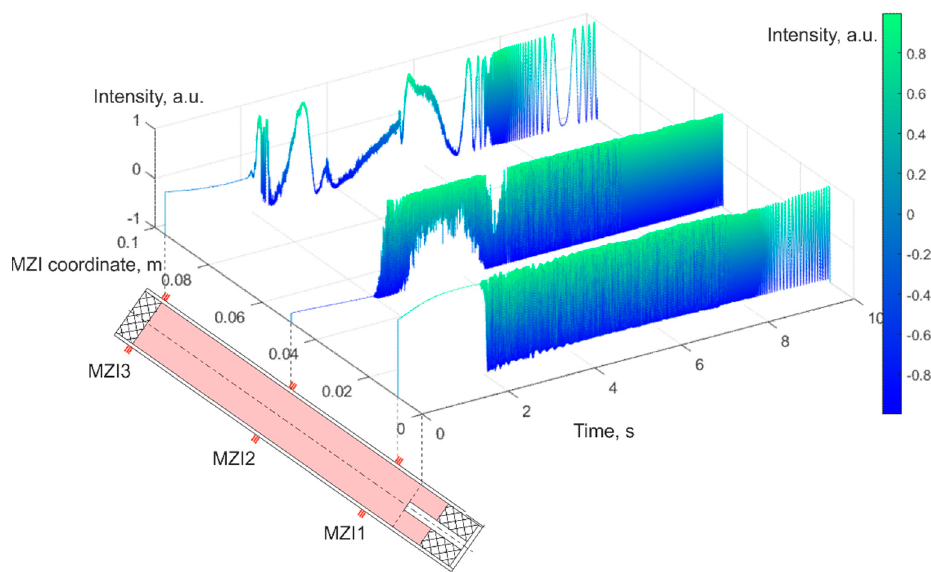
Figure 7. Plots of one data channel for each MZI.